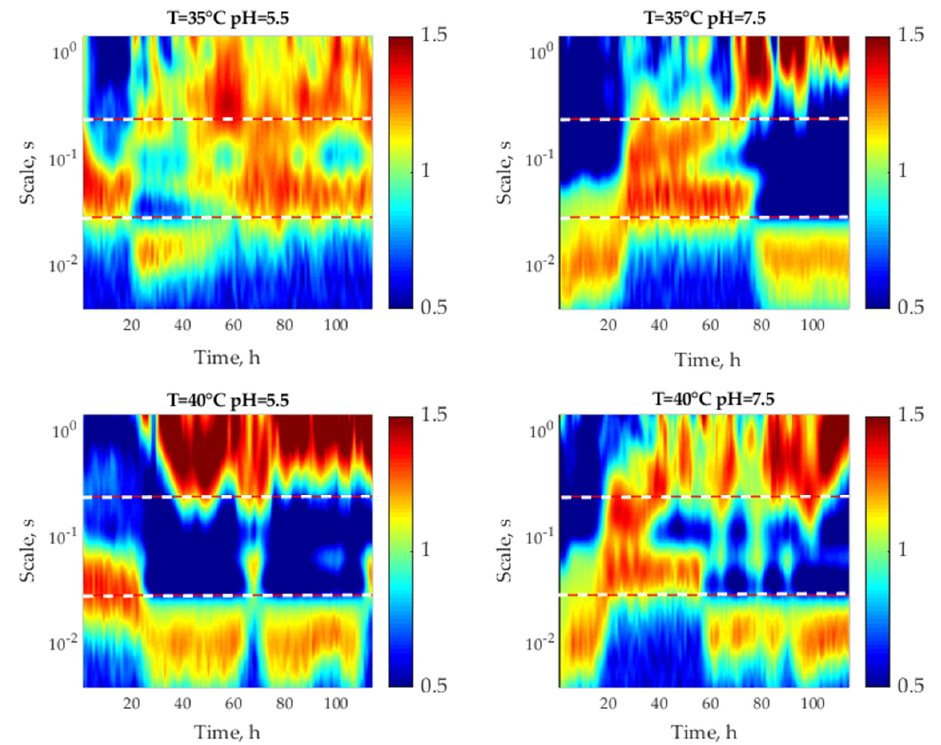
Figure 5. Scale-temporal profile of the Hurst exponent considering a 6 h moving window. Considering the four experimental conditions, Figure 6 shows the comparison between the COD measurements with Hd 1 , where it is observed that the Hd 1 dynamic exhibits the same trend observed with the COD consumption, which confirms that the time scale of Zone 1 corresponds to the hydrolysis stage in the anaerobic treatment of whey.